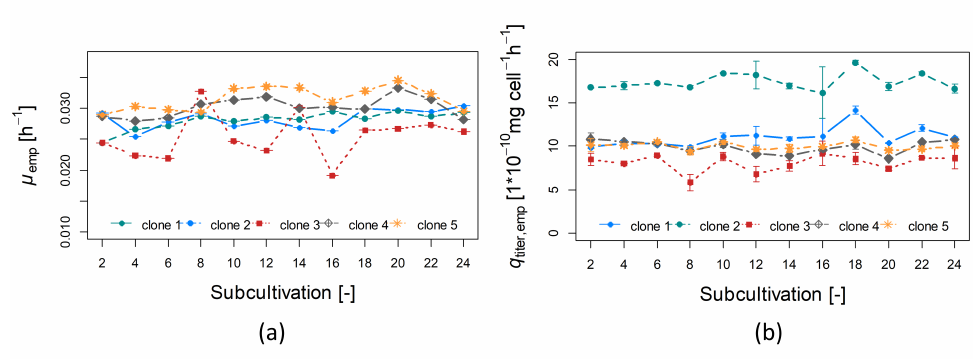
Figure 3. Growth rates µ emp ( a ) and production rates q titer,emp ( b ) for clonal populations “clone 1” to “clone5” for every second subcultivation in 50 mL OrbShake tubes.